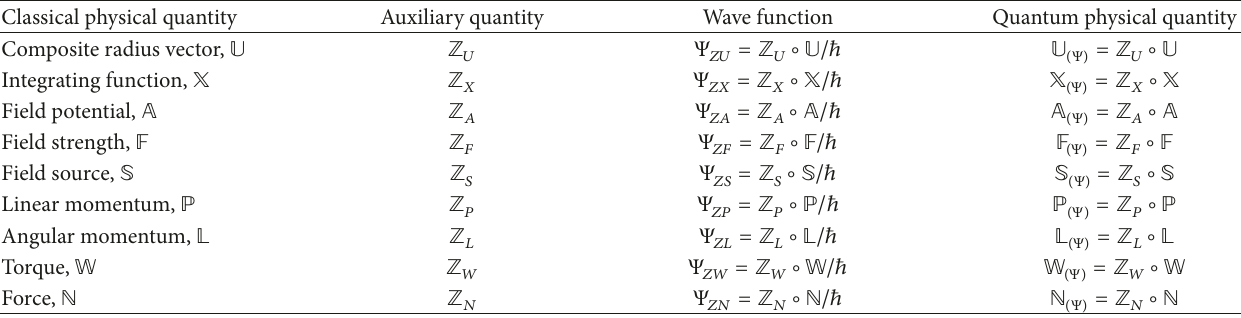
Table 3: Some classical physical quantities, auxiliary quantities, wave functions, and quantum physical quantities, in the complex-sedenion space.